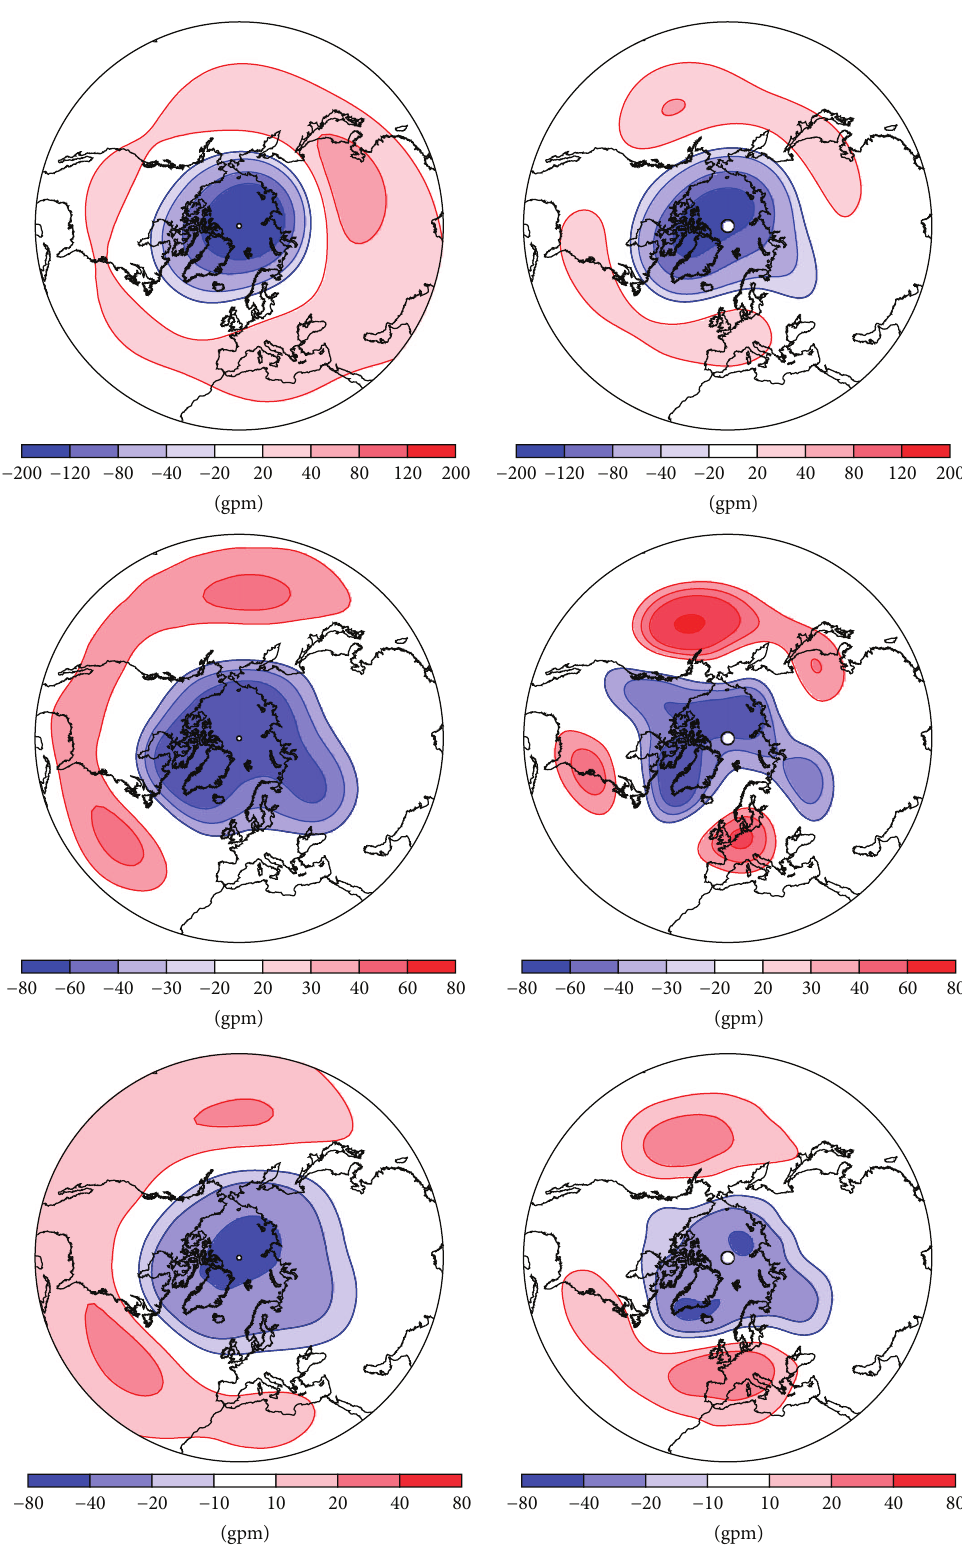
Figure 7: (Left) first EOF of geopotential height (gpm) of the (top) 167 hPa, (middle) 500 hPa, and (bottom) 833 hPa model level. (Right) same as left column, but for the layer-averaged NCEP-NCAR reanalysis